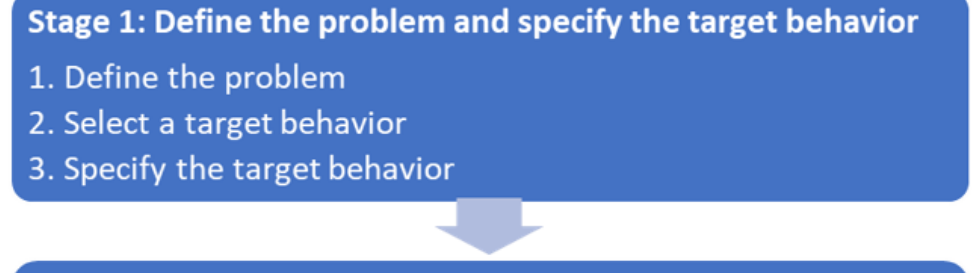
Figure 1. WorkMyWay intervention and technology development